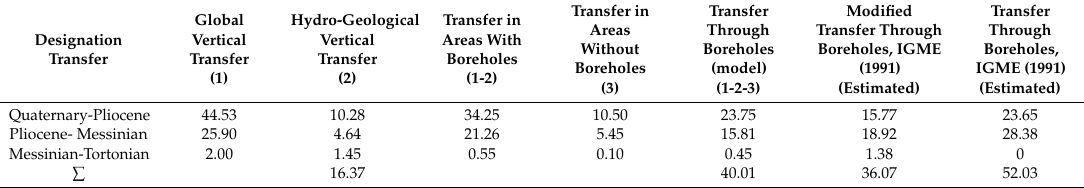
Table 6. Vertical hydraulic communication through boreholes in transient state (2010–2015) (Mm 3